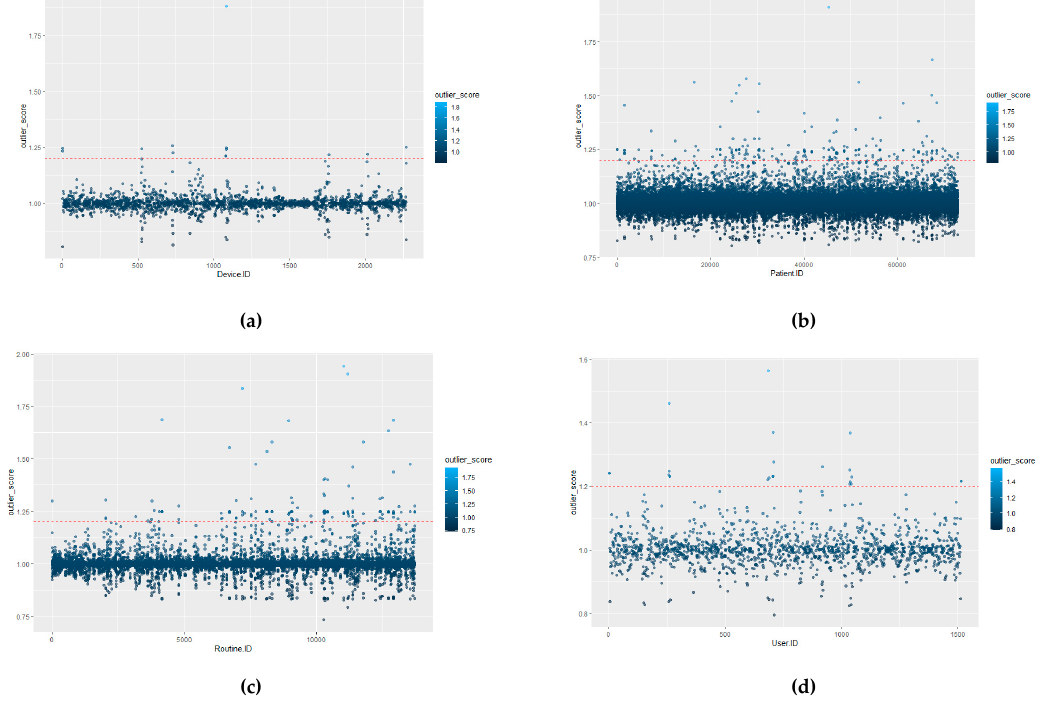
Figure 8. Local outlier factor (LOF) benchmark. ( a ) Device ID, ( b ) Patient ID, ( c ) Routine ID, and ( d ) User